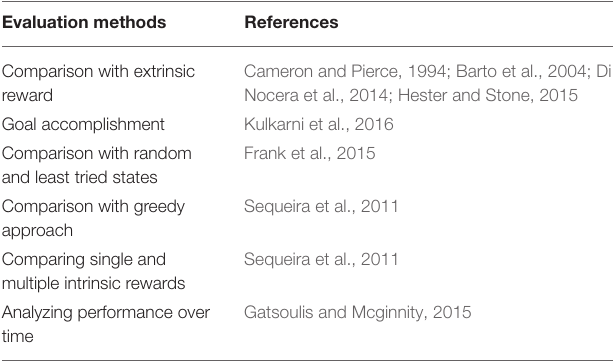
TABLE 5 | Methods used to evaluate computational models of intrinsic